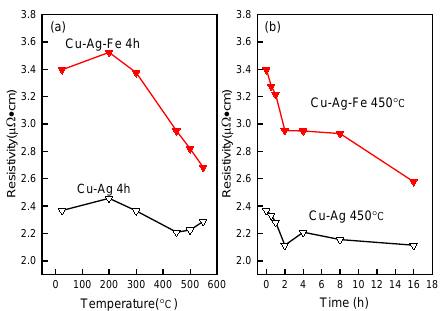
Figure 9. Electrical resistivity of aged alloys: ( a ) at different temperature for 4 h, ( b ) at 450 °C for different time.